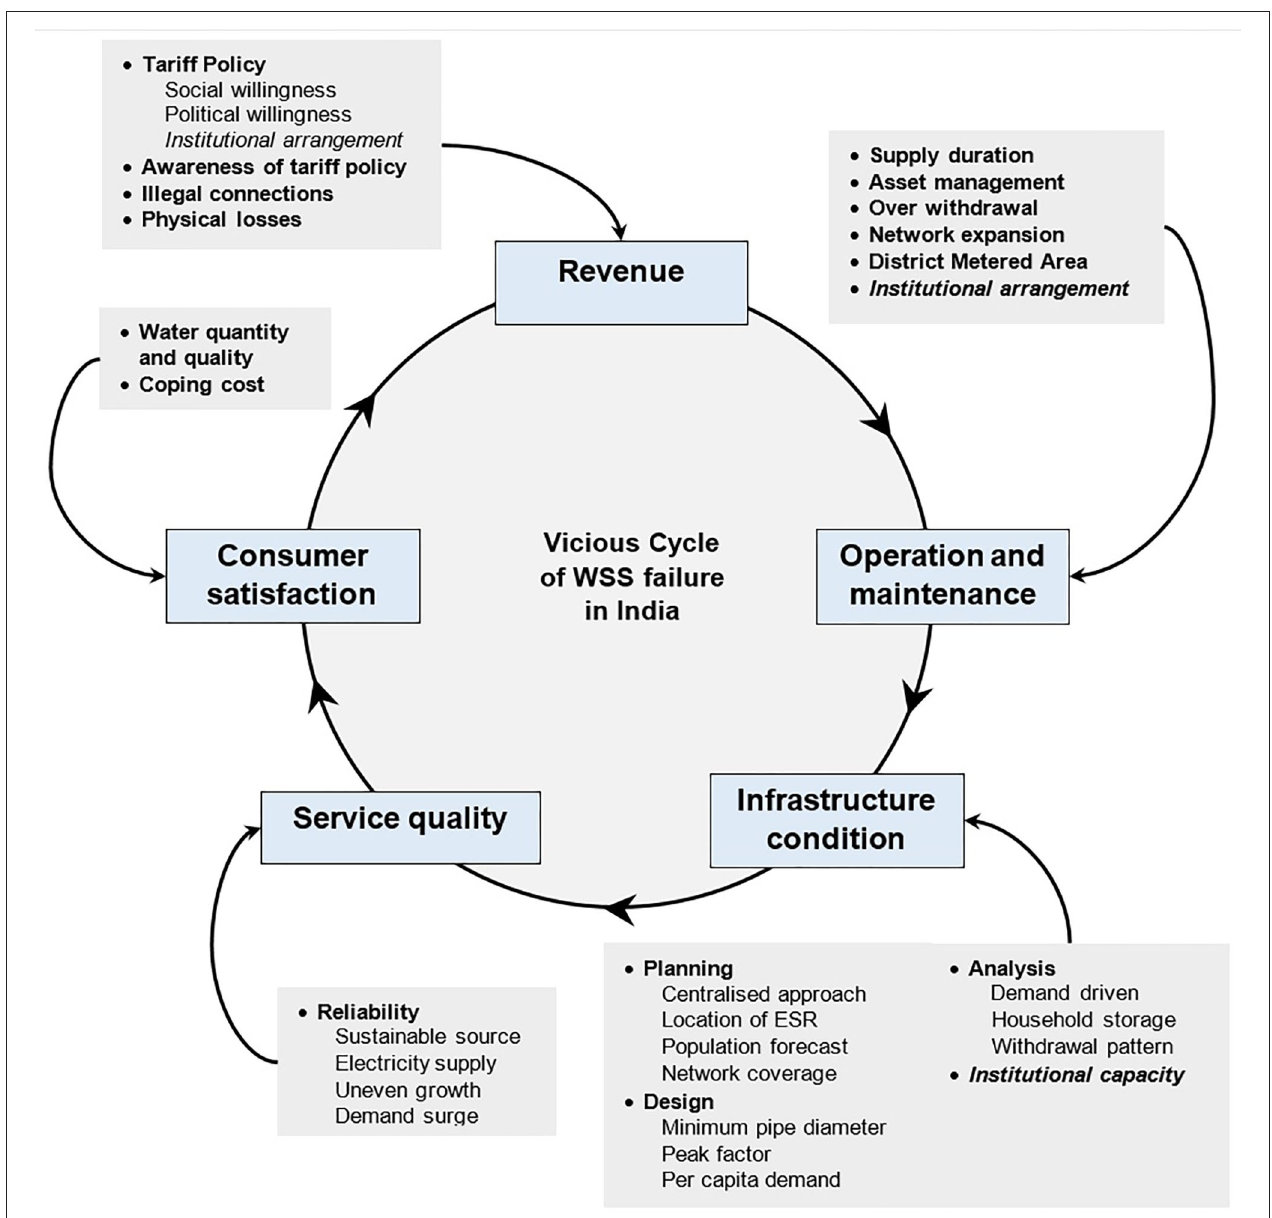
FIGURE 3 | Vicious cycle of WSS failure in